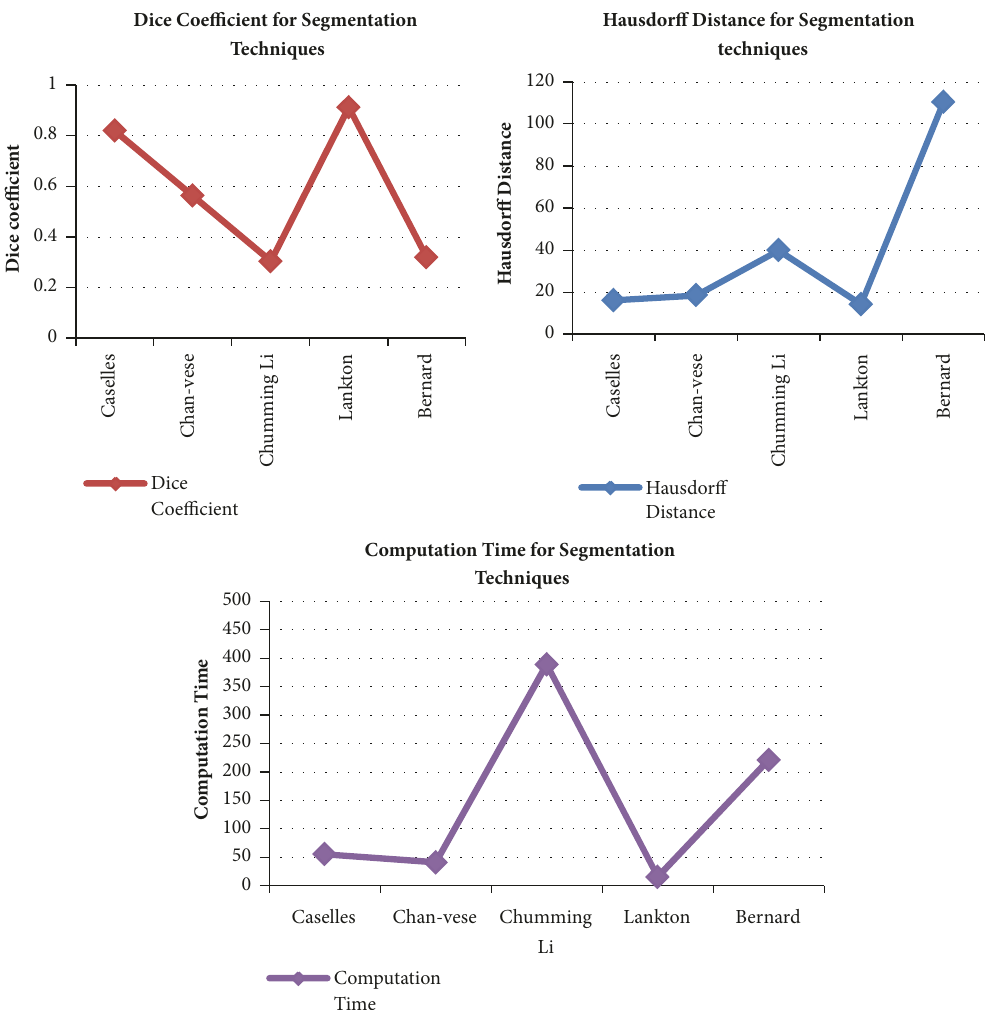
Figure 2: Graphical representation of the performance metrics of five different active contour techniques.